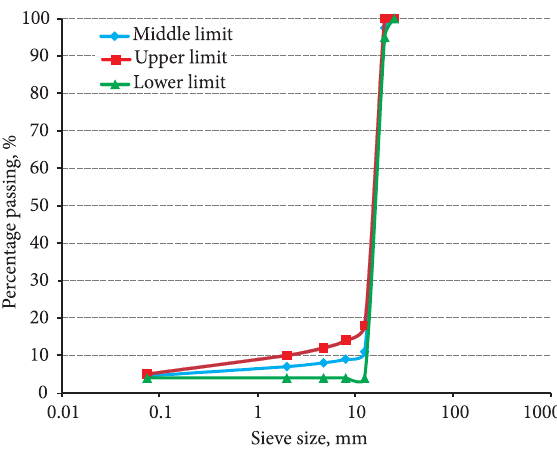
Fig. 1. Open-graded asphalt gradation